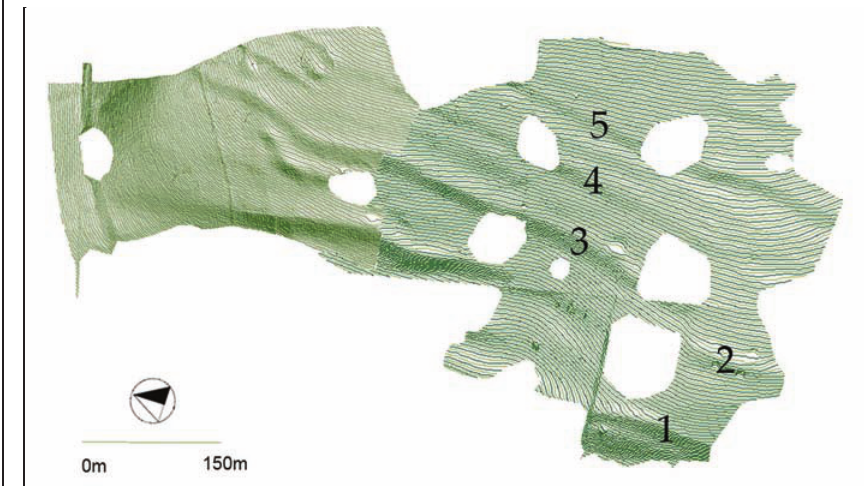
Figure 2 Map of the Little Combes Hill lynchets (after Davis 2007)